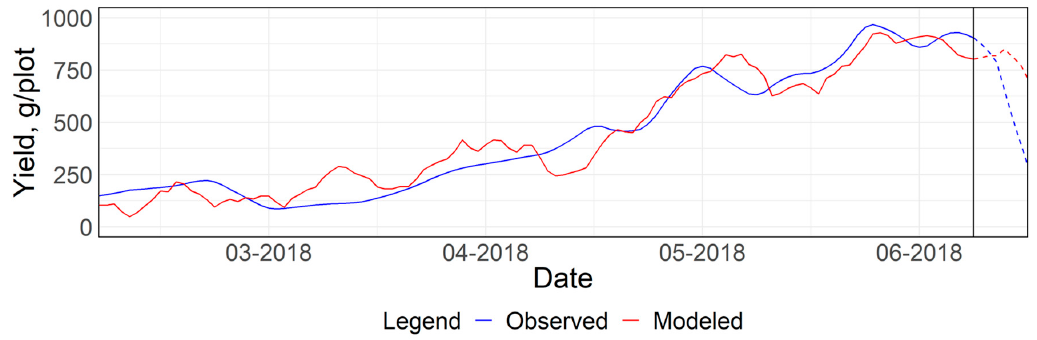
Figure 8. The vertical line separates the sample from the training and testing.